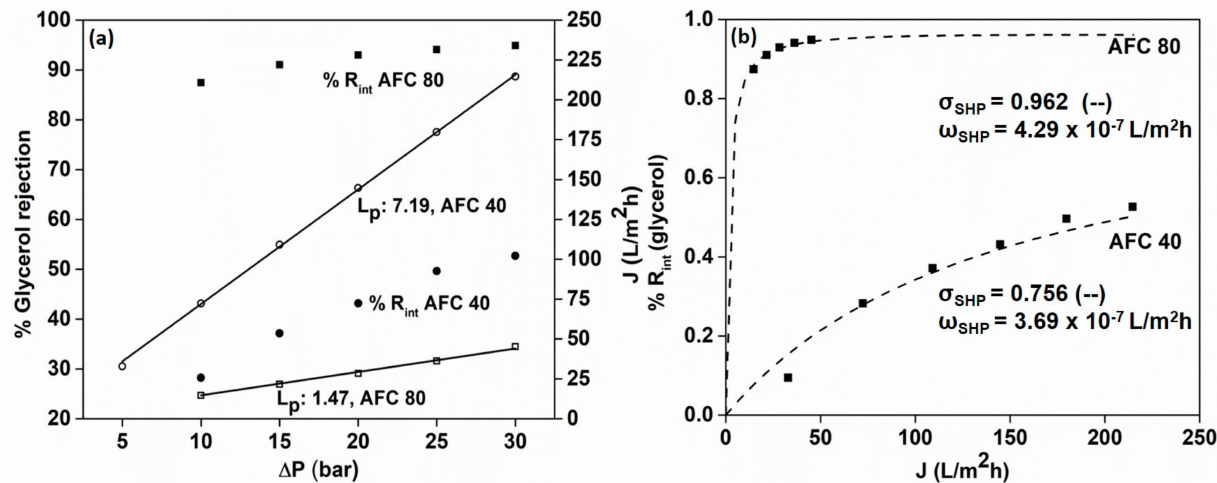
Figure 4. ( a ) Rejection of glycerol by the AFC 40 and AFC 80 membranes and ( b ) SHP model